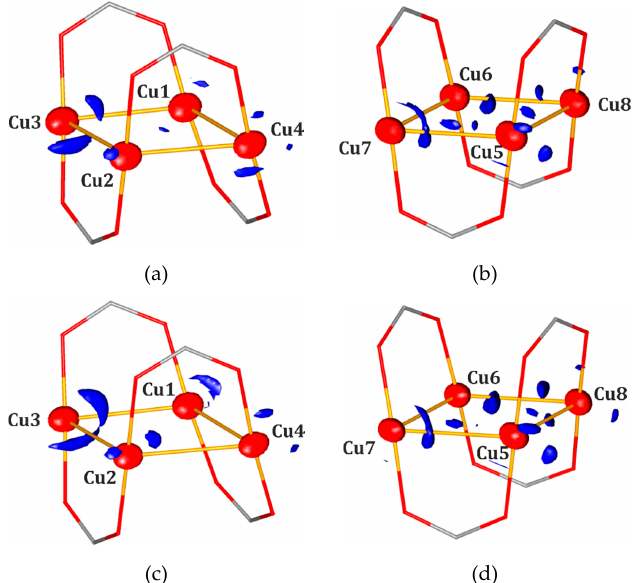
Figure 9. Photodifference maps ( F ON o − F OFF o ) drawn for 90 K ( a , b ) and 225 K ( c , d ) time-resolved Laue data collections: ( a,c ) molecule A, ( b,d ) molecule B. Blue isosurface—positive, red—negative ( − 2.0 e·Å − 3 & +0.9 e·Å − 3 , and − 1.5 e·Å − 3 & +0.5 e·Å − 3 for top and bottom panels, respectively); only selected atoms are shown for clarity.